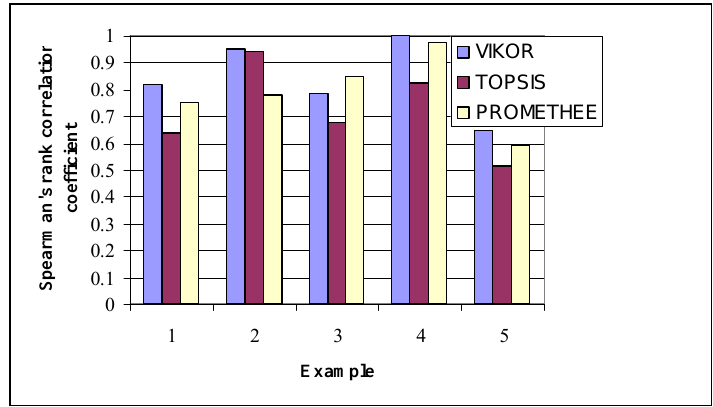
Fig. 1. Comparison between MCDM methods for five